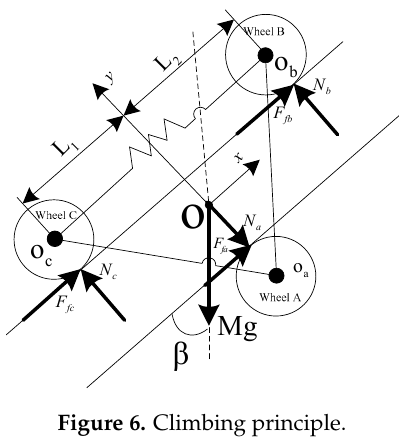
Figure 6. Climbing principle.